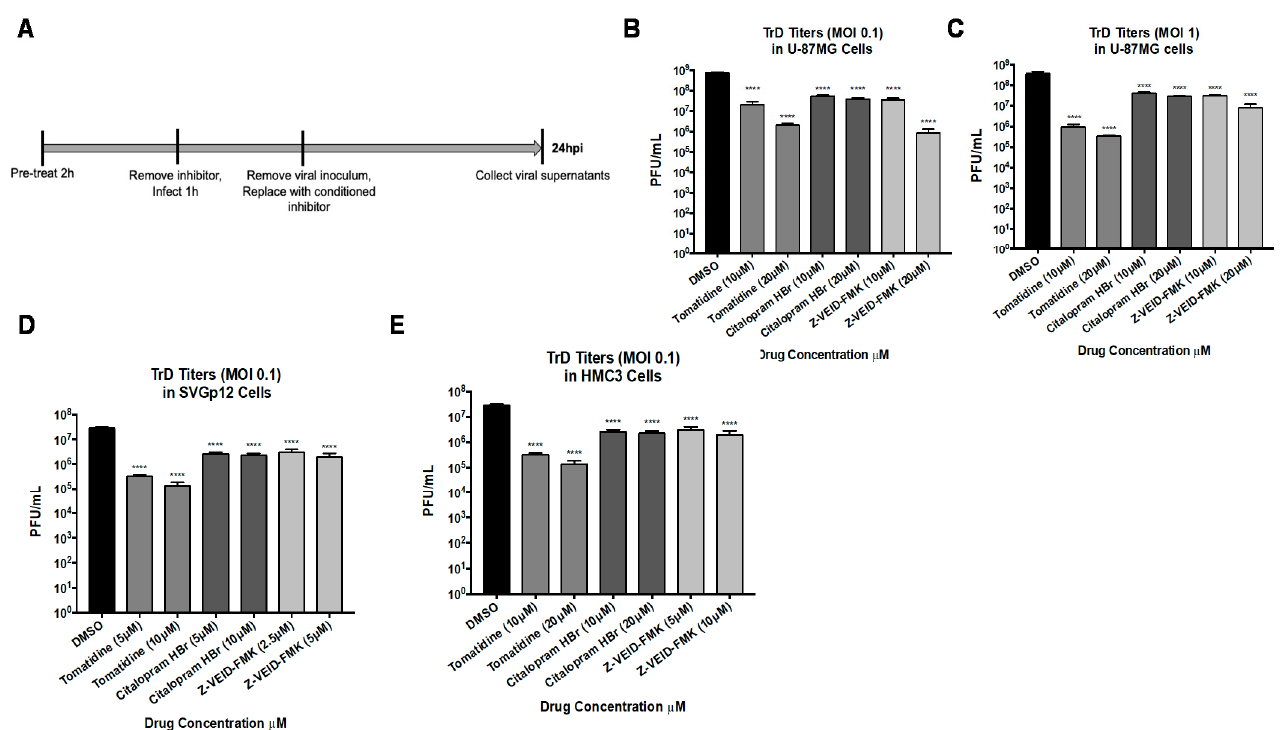
Figure 6. Tomatidine, citalopram HBr, and Z-VEID-FMK display efficacy against the wild-type VEEV Trinidad donkey strain in a cell-type independent manner. ( A ) Schematic of infection scheme. Cells were pretreated with two nontoxic concentrations of tomatidine, citalopram HBr, or Z-VEID-FMK for 2 h, subsequently infected with VEEV TrD at MOI 0.1 ( B , D , E ) or MOI 1 ( C ) for 1 h, and conditioned media were replaced after the removal of viral inoculum. Viral supernatants were evaluated by plaque assay, as described in Materials and Methods. ( B , C ) Efficacy in U-87MG cells at MOI 0.1 and 1, respectively. ( D ) Efficacy in SVGp12 cells. ( E ) Efficacy in HMC3 cells. Graphs are representative of two independent experiments performed in technical triplicates ( n = 6). **** p < 0.0001.